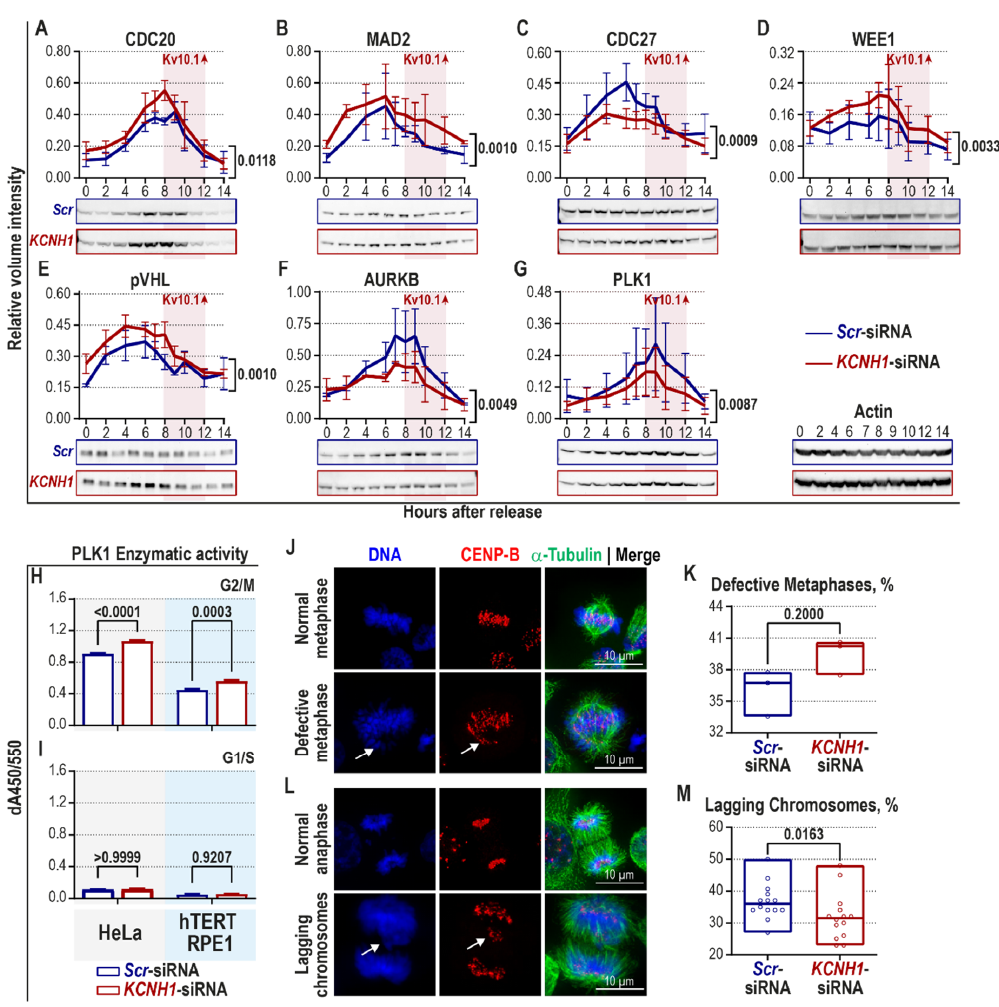
Figure 2. Activation of SAC in Kv10.1-depleted HeLa cells decreases the occurrence of lagging chromosomes. HeLa cells were transiently transfected with either Scr - or KCNH1 -siRNA and